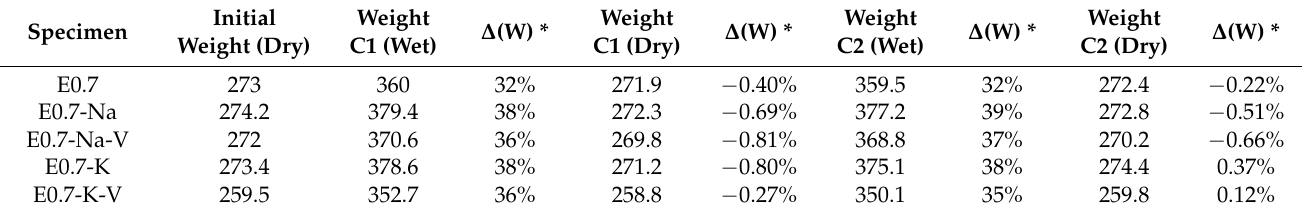
Table 8. Water–stove cycles test weight variation